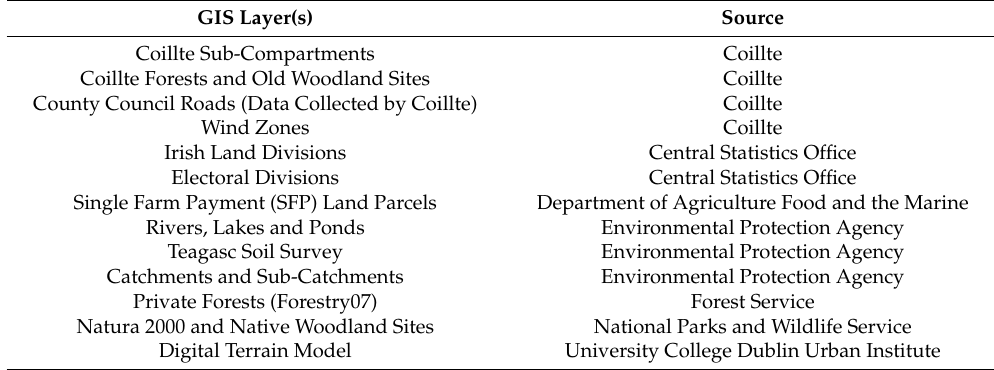
Table 3. List of GIS layers and their